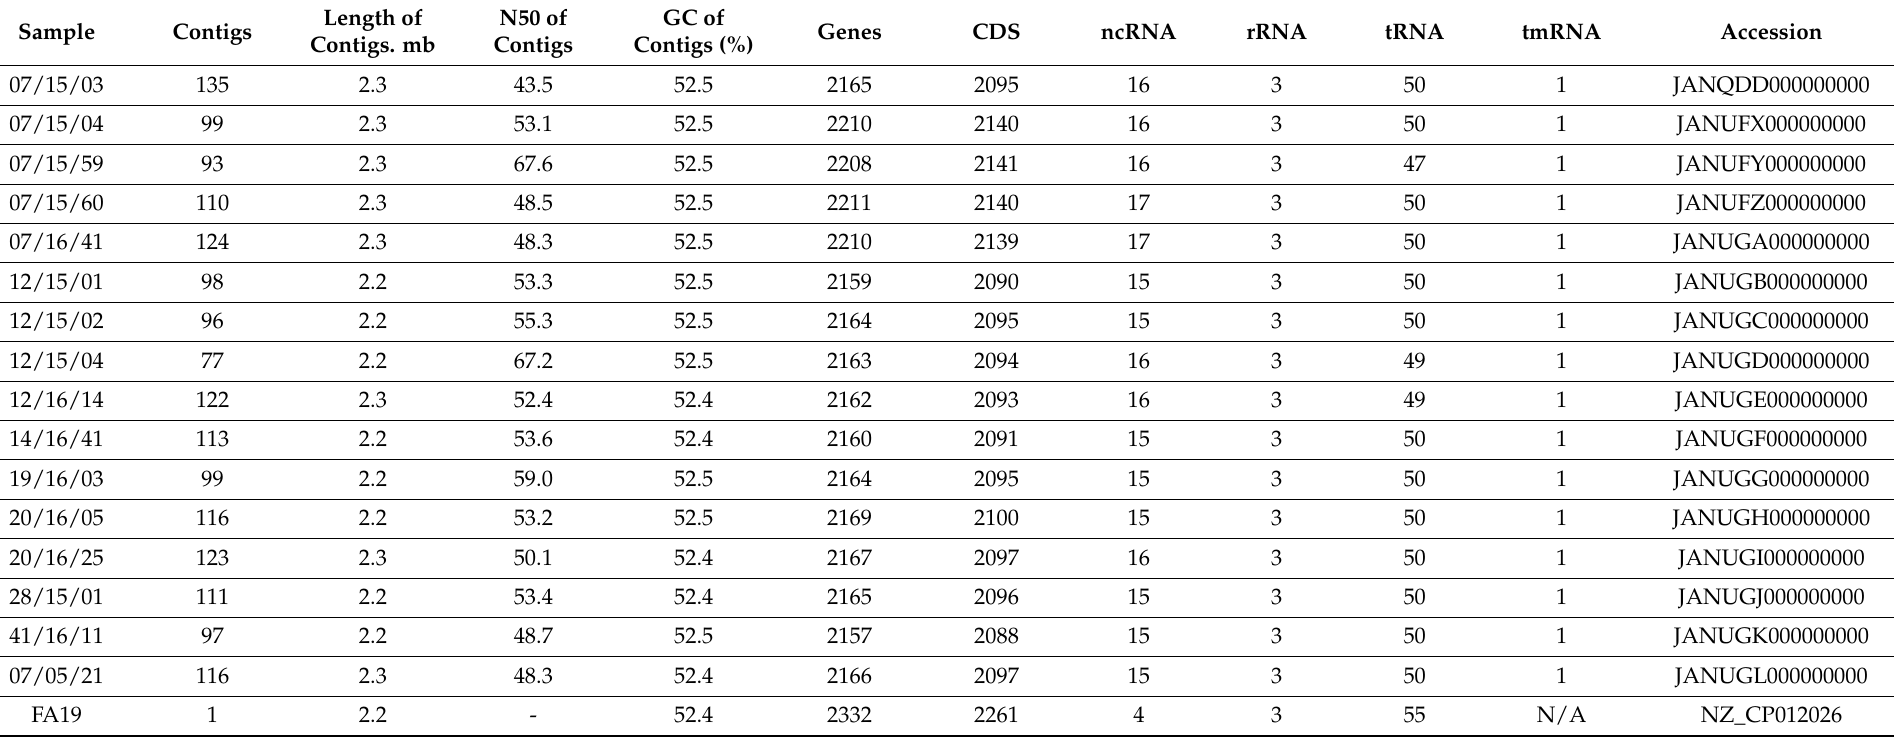
Table 2. General characterization of the genomes of Russian strains of Neisseria gonorrhoeae G807 NG-MAST GENOGROUP/ST1594 MLST and the reference strain FA19